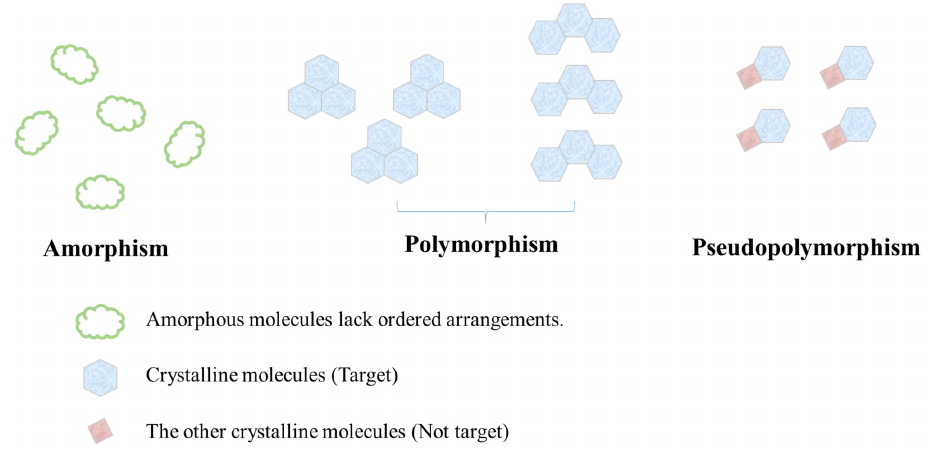
Figure 3. The difference among amorphism, polymorphism, and pseudo-polymorphism.